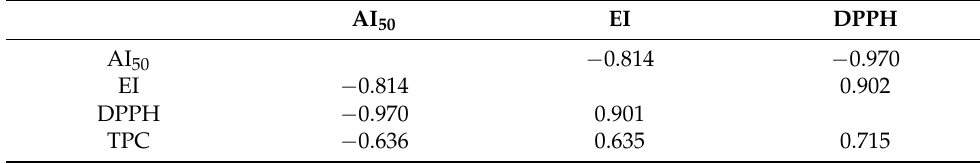
Table 3. Pearson ´ s correlation coefficients for AI 50 , EI, DPPH and TPC (total phenolic